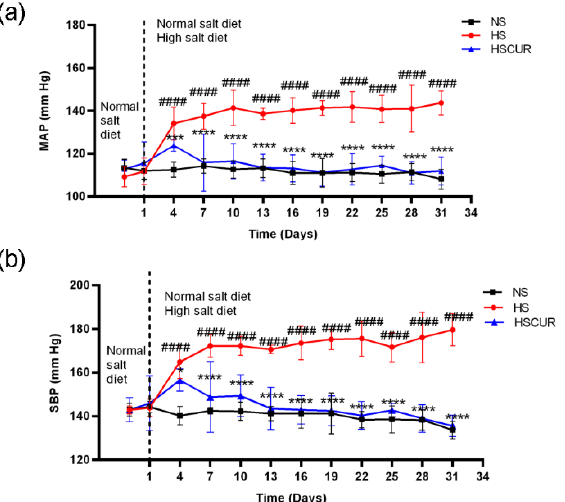
Figure 1. Curcumin reverted the high-salt diet (HSD)-induced increase in blood pressure. Changes in mean arterial pressure ( a ), and systolic blood pressure ( b ) among normal salt (NS), high salt (HS),